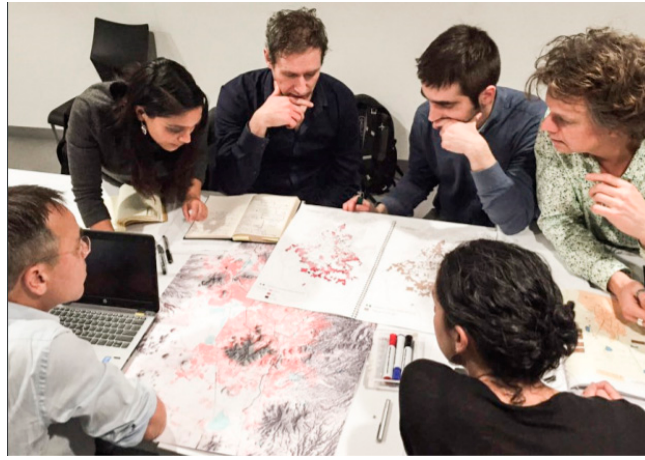
Figure 4. Impression of the water workshop in Mexico City (photo by: Víctor Manuel Rico Espínola) [64,65].